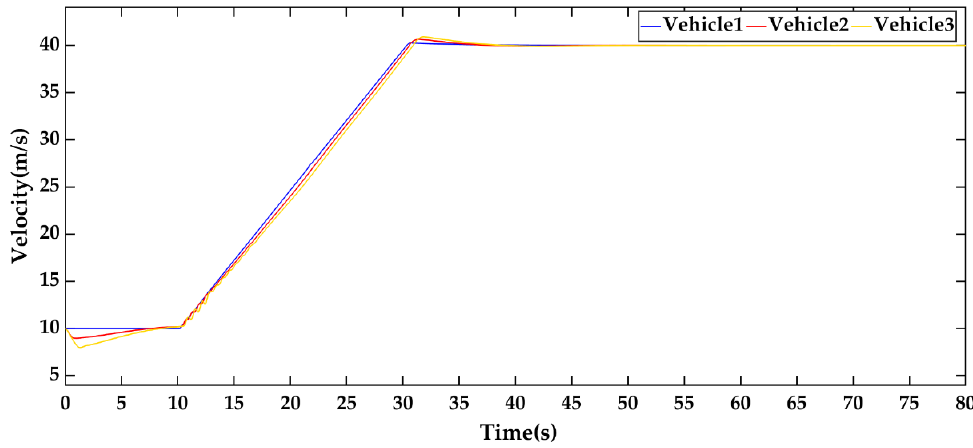
Figure 9. The velocities of the following vehicle under the standard MPC strategy in Scenario 1.